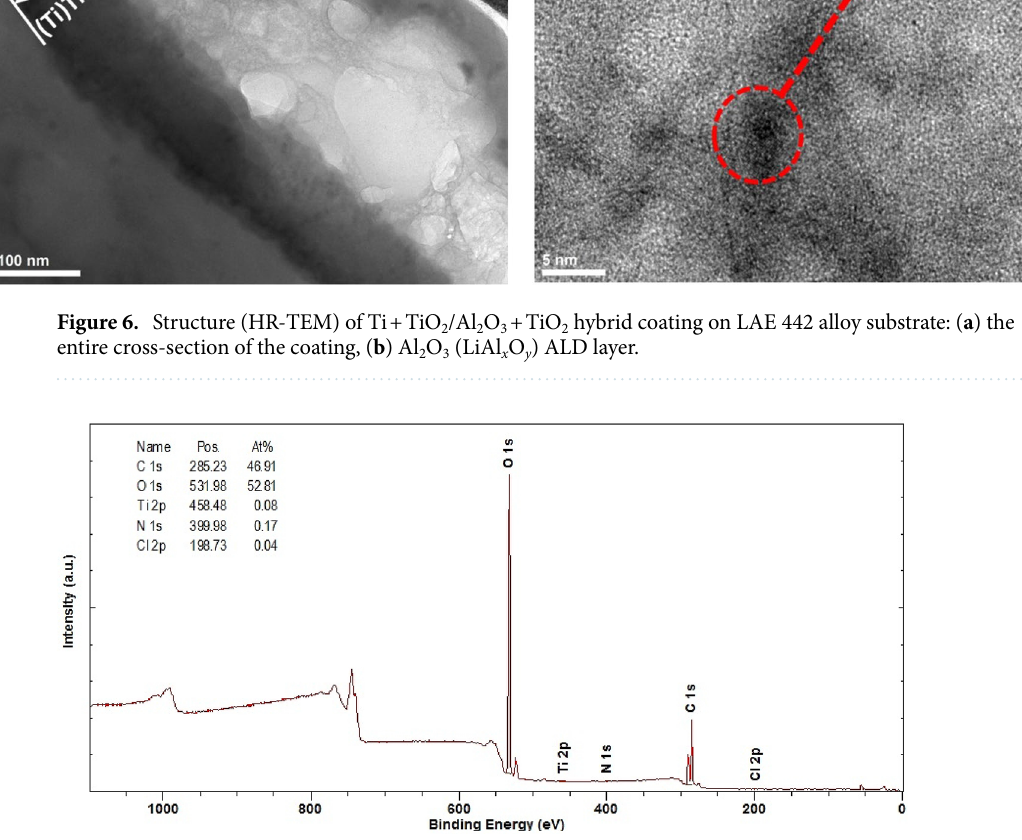
Figure 7. XPS spectrum of Ti + TiO 2 /Al 2 O 3 + TiO 2 coating on LAE442